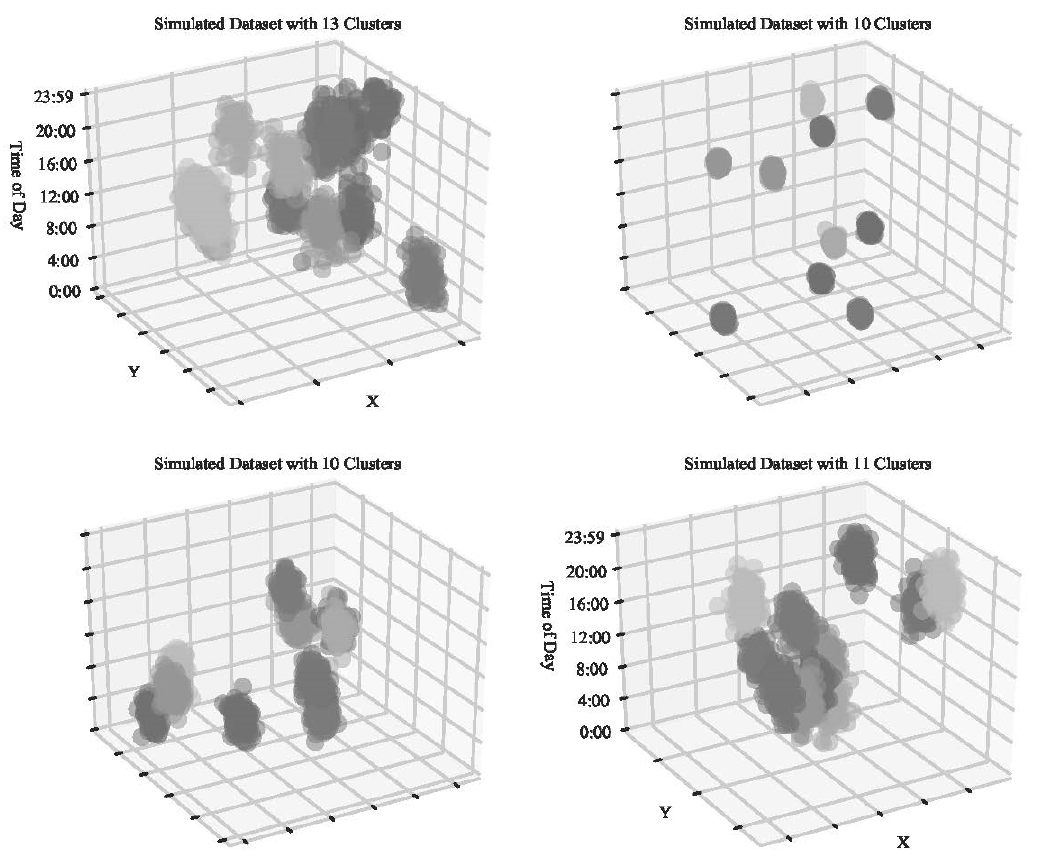
Figure 3. Example simulated datasets of random different cluster groupings, used to evaluate the nearest neighbor and temporal scale parameters.